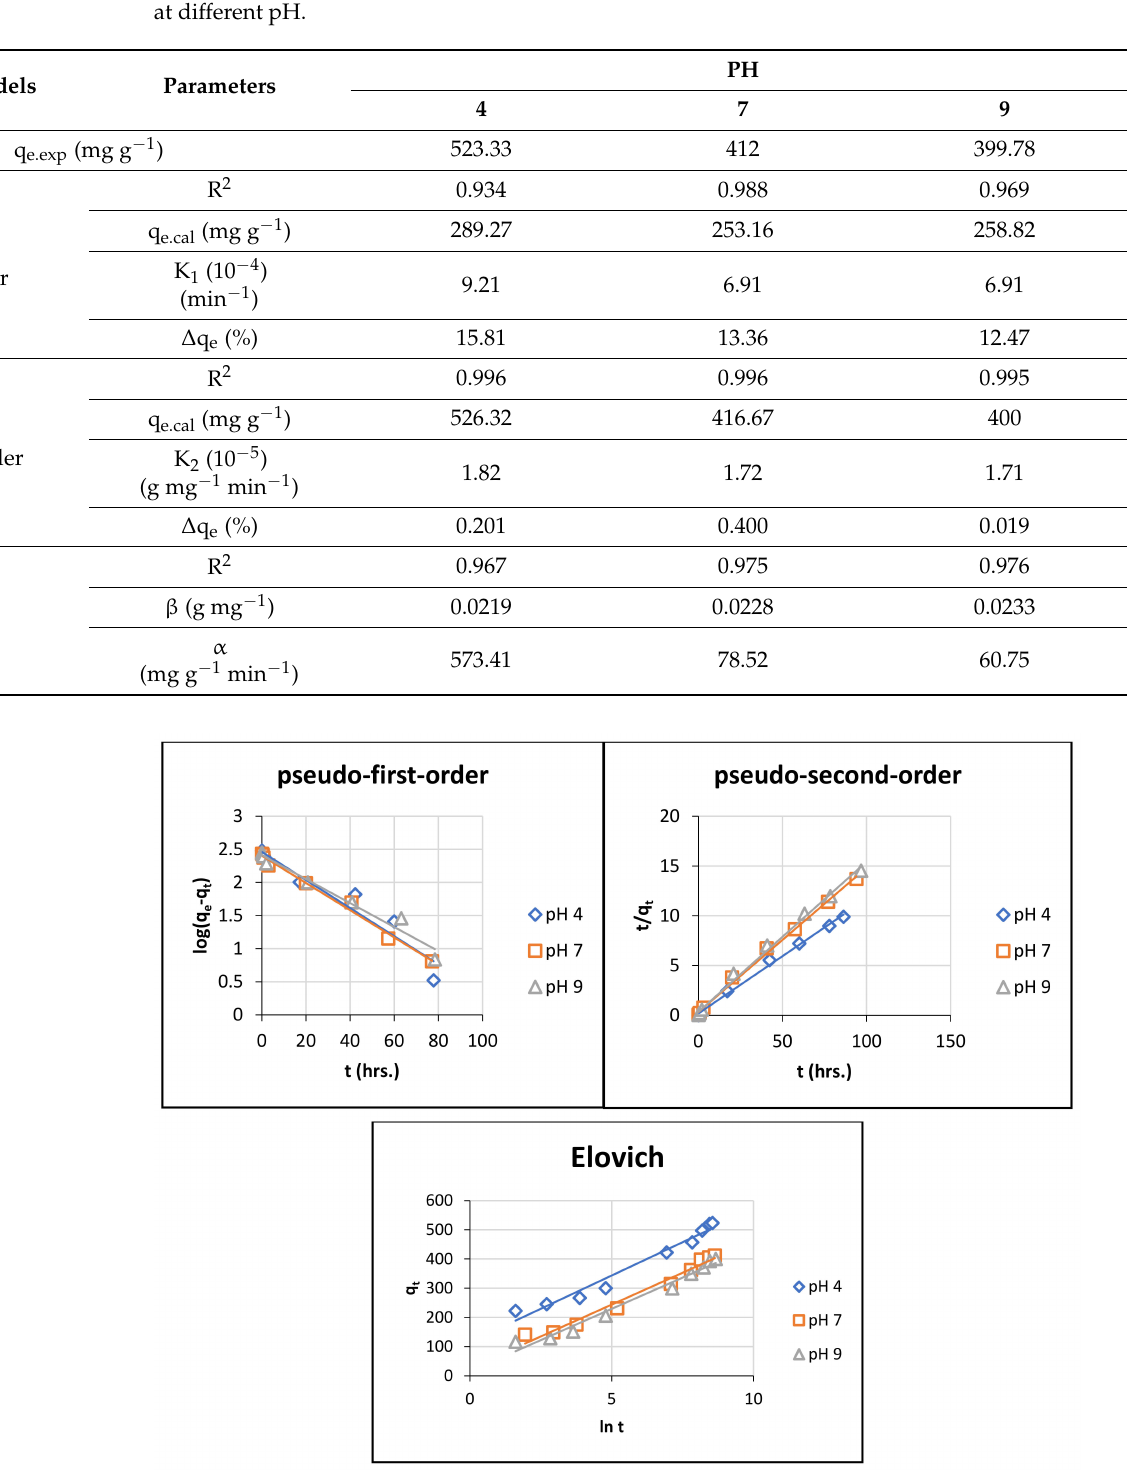
Figure 8. Linear regressions of kinetic plots at different pH for the adsorption of CR dye onto UCs (Experimental conditions: 50 mg of adsorbent, 50 mL of dye solution (600 mg L − 1 ) and temperature 55 ◦